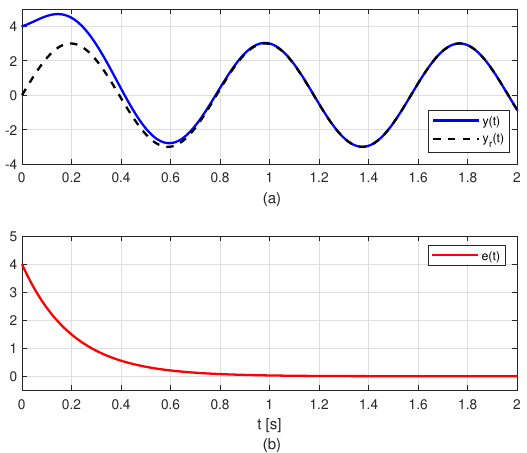
Figure 1. Regulator performance with Γ = [ 4.9348,8, − 10 ] : ( a ) Comparison of the output y ( t ) and the reference y r ( t ) , ( b ) Error between y ( t ) and y r ( t ) .